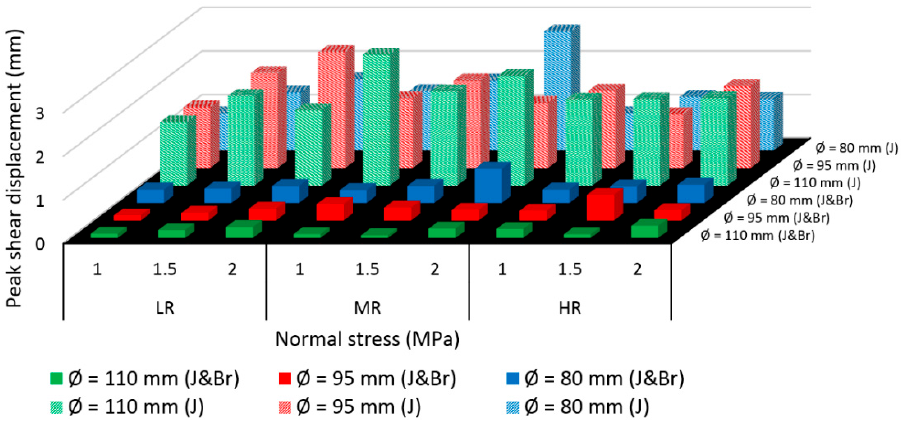
Figure 13. Comparison of peak shear displacements of J and J&Br specimens.